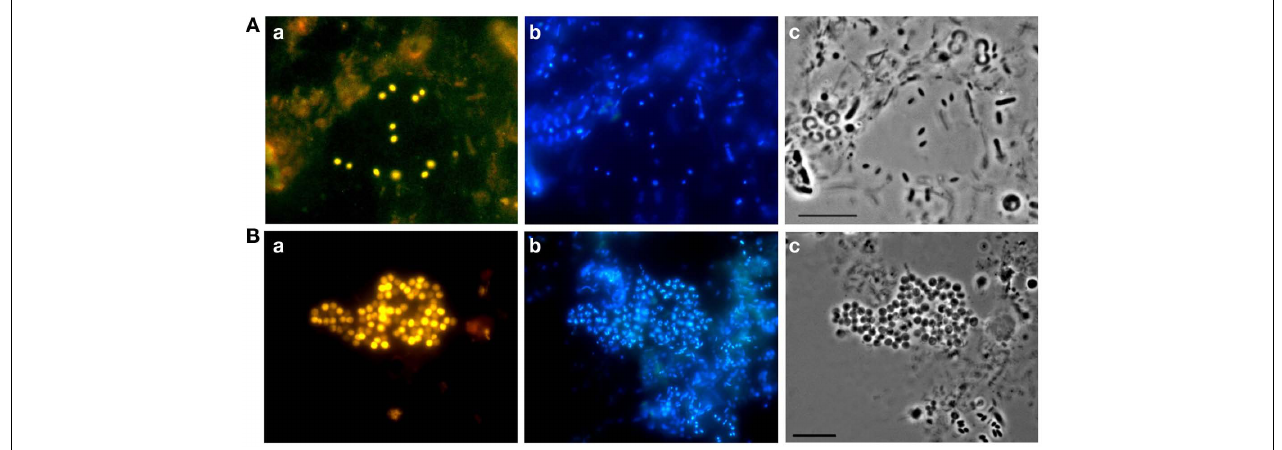
FIGURE 3 | Specific detection of acidobacteria (A) and planctomycetes (B) in microbial biofilms by FISH: epifluorescence micrographs of in situ hybridization with probes HoAc1402 (Aa) and Pla46 + Pla886 (Ba), DAPI staining (b), and the respective phase-contrast images (c). Scale bars, 10 μ m.